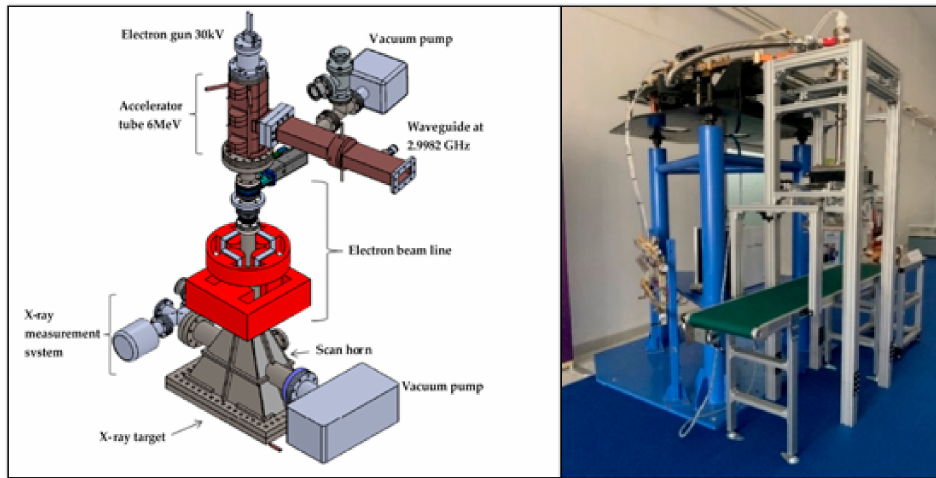
Figure 9. Linear Accelerator system for X-ray sterilization.